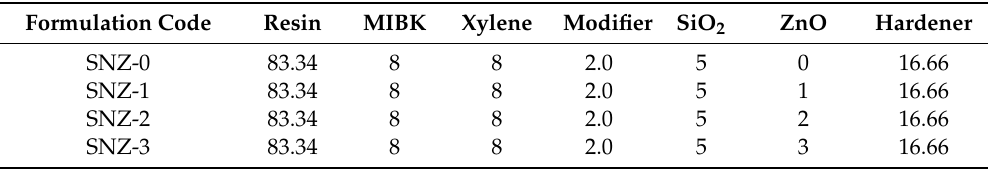
Table 1. Compositions (in wt.%) of the nanoparticle-modified formulations. Formulation